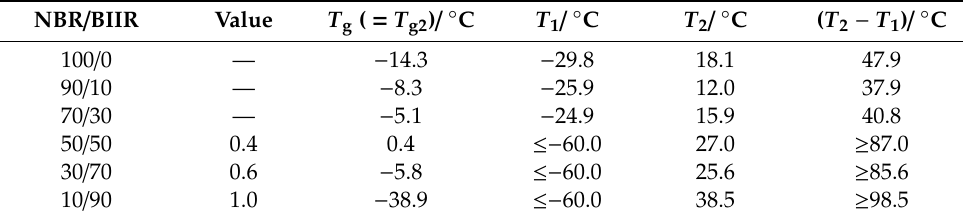
Table 3. Damping property parameters of NBR / BIIR with various blend ratios.